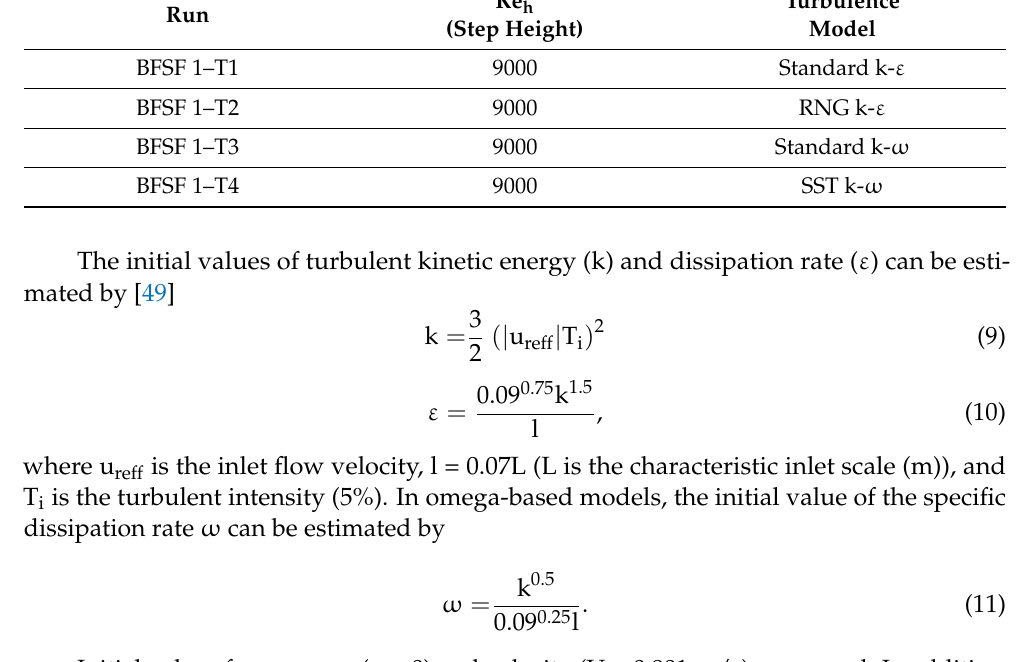
Table 5. Runs of turbulent flow over the classical backward-facing step at different turbulence models. Re h Turbulence Run (Step Height) Model BFSF 1–T1 9000 Standard k- ε BFSF 1–T2 9000 RNG k- ε BFSF 1–T3 9000 Standard k- ω BFSF 1–T4 9000 SST k- ω